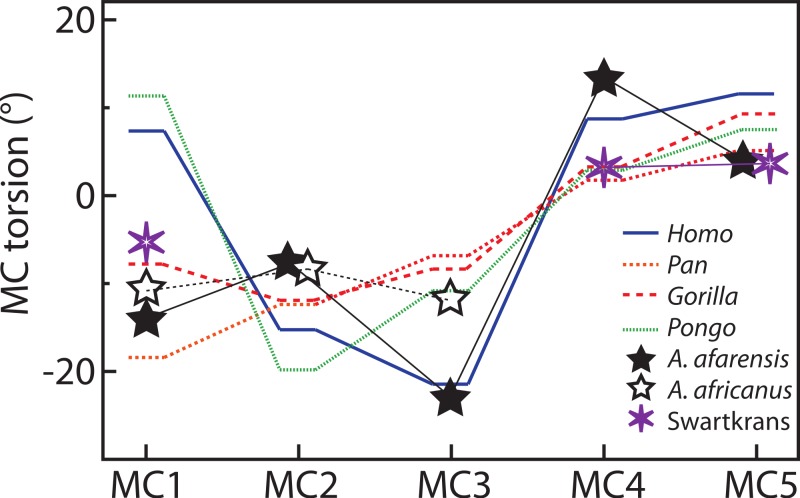
Patterns of metacarpal torsion.Patterns of torsion for all MCs (median values for samples of n > 1).